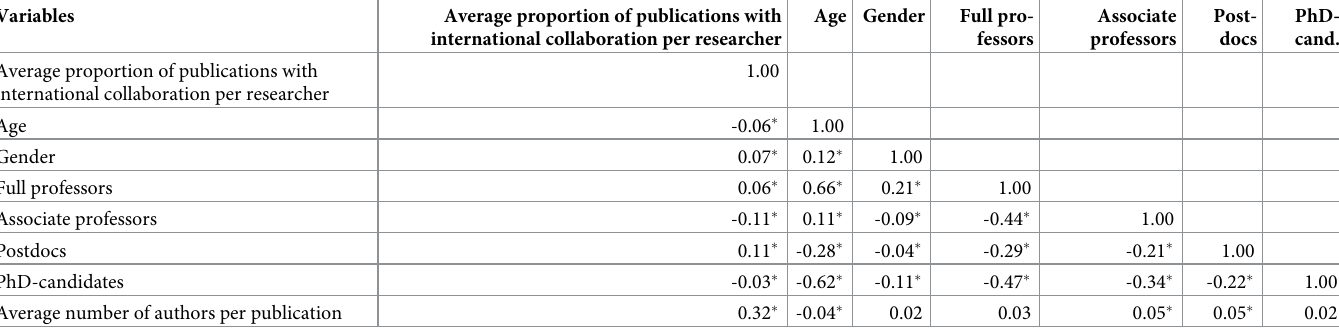
Table 4. Correlation matrix. Average proportion of publications with international collaboration per researcher and selected variables.